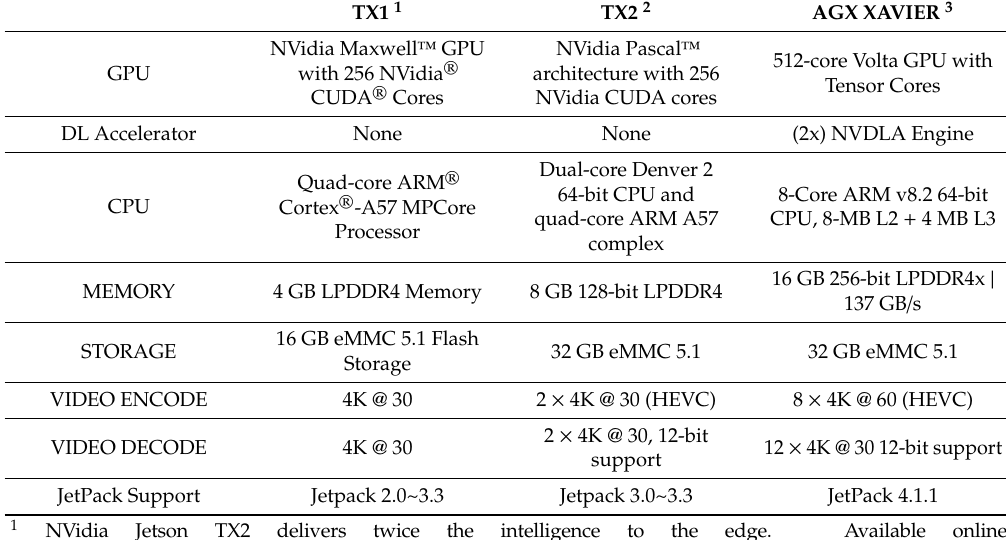
Table 2. Comparison between Jetson modules used for target detection and